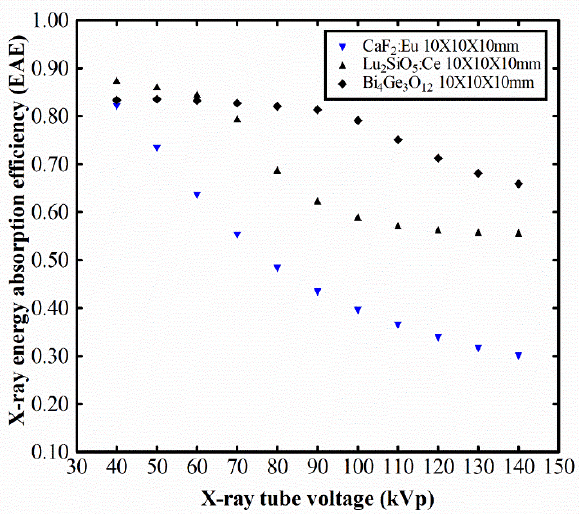
Figure 4. Energy absorption efficiency (EAE) of the CaF 2 :Eu crystal along with data for LSO and BGO.